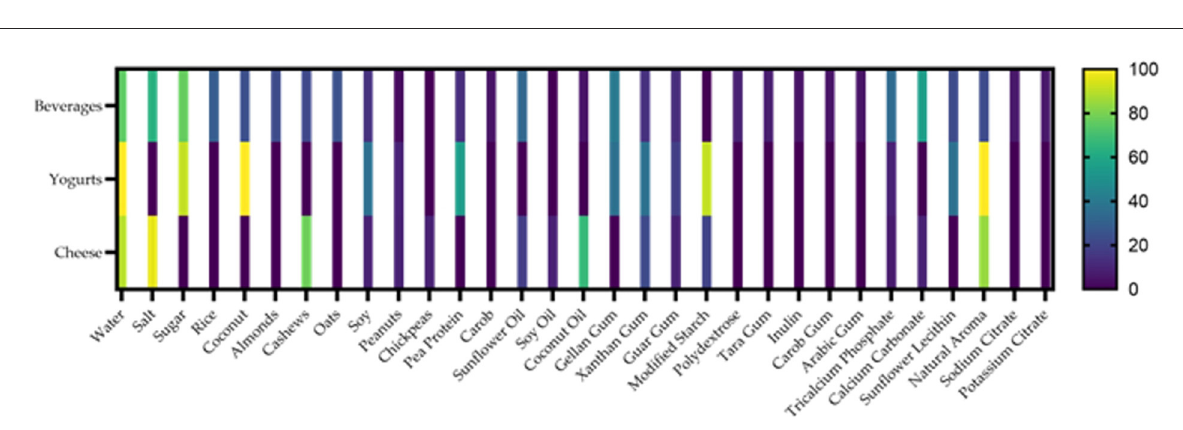
FIGURE5 Percentages of frequencies of implemented ingredients in vegan milk derivatives in a heatmap. Colored clusters represent different frequencies according to the scale placed on the right